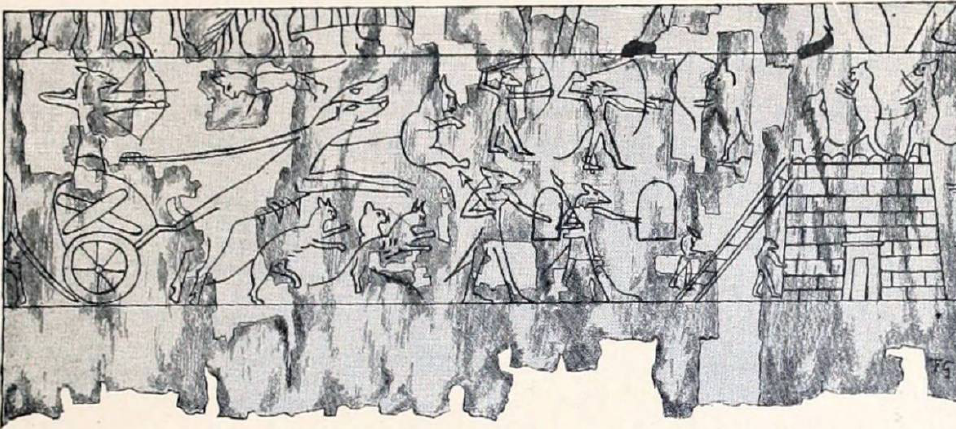
Figure 7. Reconstruction of the animal battle scene of Turin Papyrus 55001 (CME inv. no. C.2031) (Taken from Gaston Maspero, The Struggle of the Nations (London: S.P.C.K., 1896), p. 453).